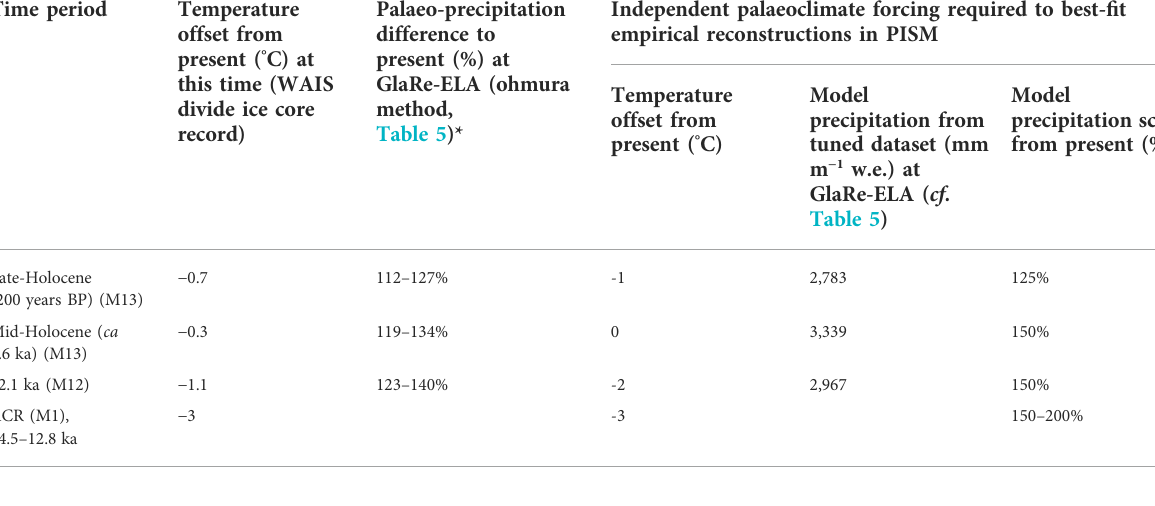
TABLE 7Calculationsof precipitation basedupon GlaRe-ELAreconstructions following themethodofOhmura etal.(1992)undergiventemperature offsets from present (West Antarctic Ice Sheet (WAIS) Divide surface air temperature reconstruction (Cuffey et al., 2016). Temperature and precipitation forcing combinations which initialise the ice cap model to best fi t empirical ice extent reconstructions are also